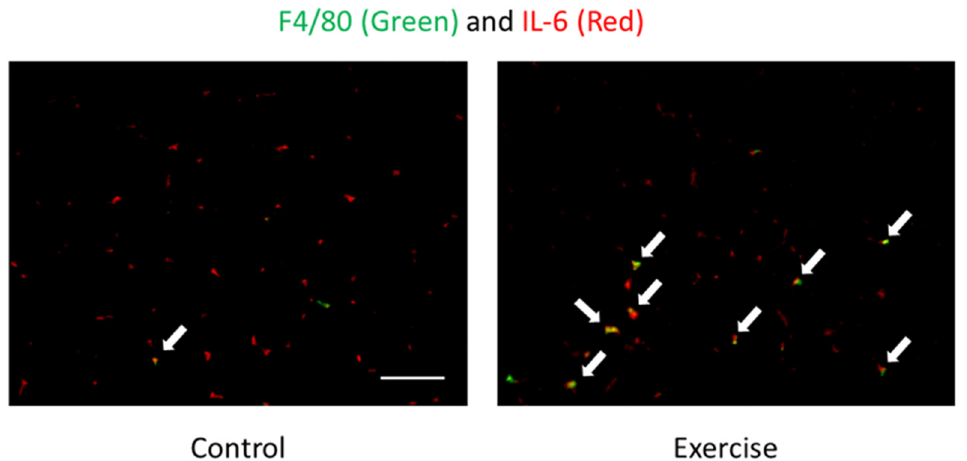
Figure 1. Localization of F4 / 80 (macrophages) (green) and IL-6 (red) of skeletal muscle after exercise detected by immunofluorescence staining [61]. Arrows (yellow) indicate F4 / 80 and IL-6 double positive cells. The signals of IL-6 were mainly observed in the interstitial space. Exercise increased F4 / 80 and IL-6 double positive cells but not IL-6 positive myocytes. This result suggests macrophages are one of the sources of IL-6.